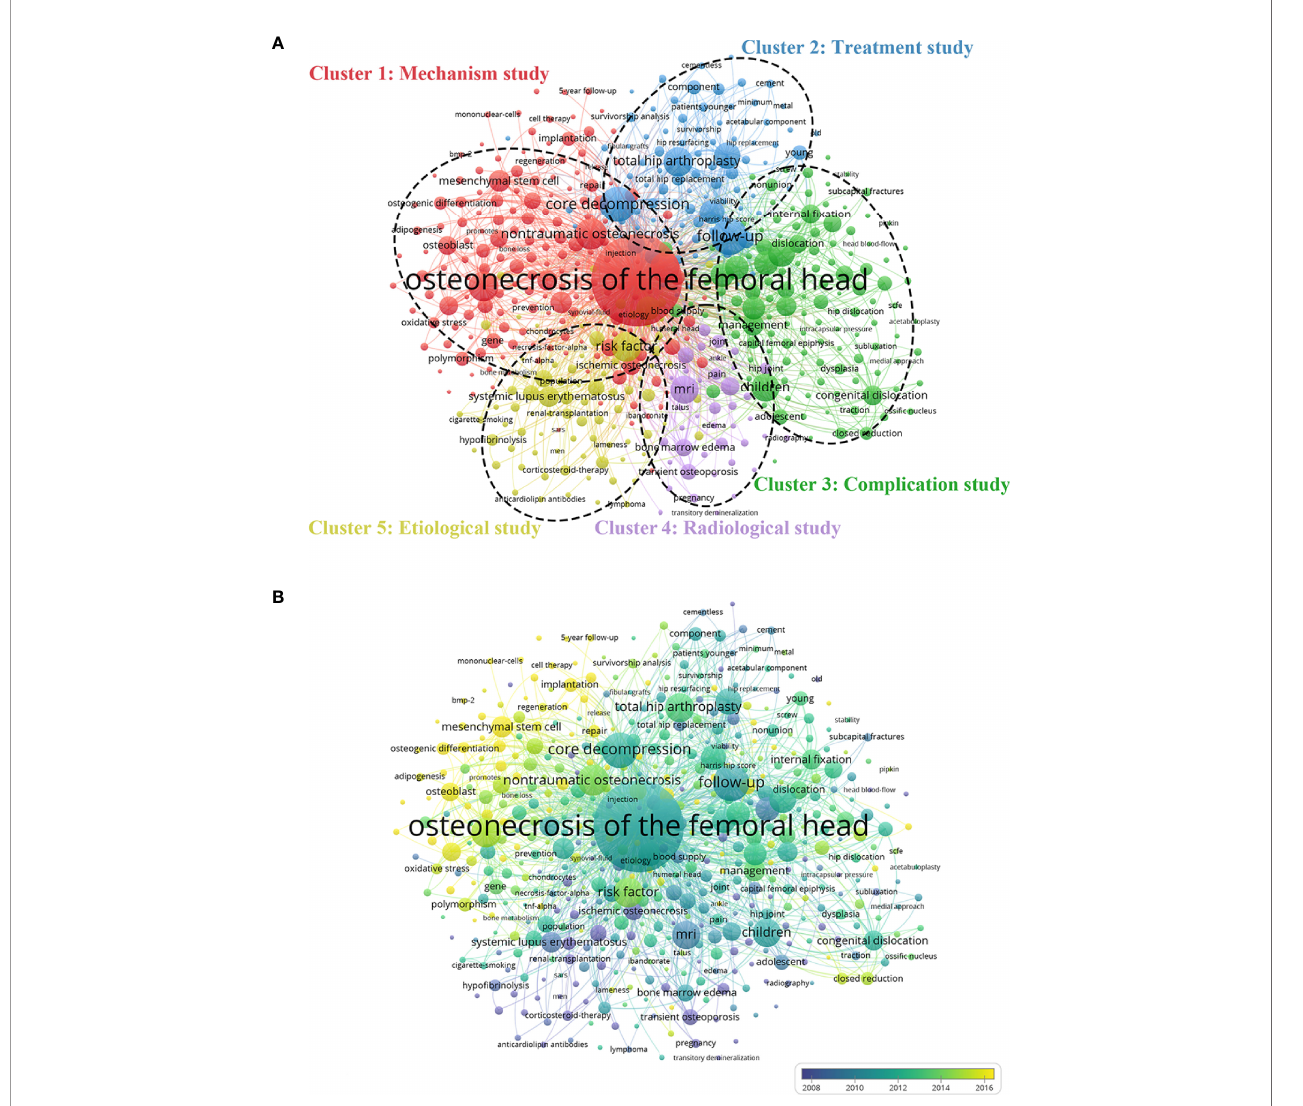
FIGURE 8 | Co-occurrence analysis of global publications in ONFH in the last 30 years. (A) Network visualization of 515 identi fi ed keywords in ONFH. All the keywords are divided into 5 clusters: “ Mechanism study ” , “ Treatment study ” , “ Complication study ” , “ Radiological study ” and “ Etiological study ” . (B) Overlay visualization of the 515 identi fi ed keywords in ONFH based on the average time they appeared in the publications. The blue keyword appeared earlier, while the yellow keyword appeared